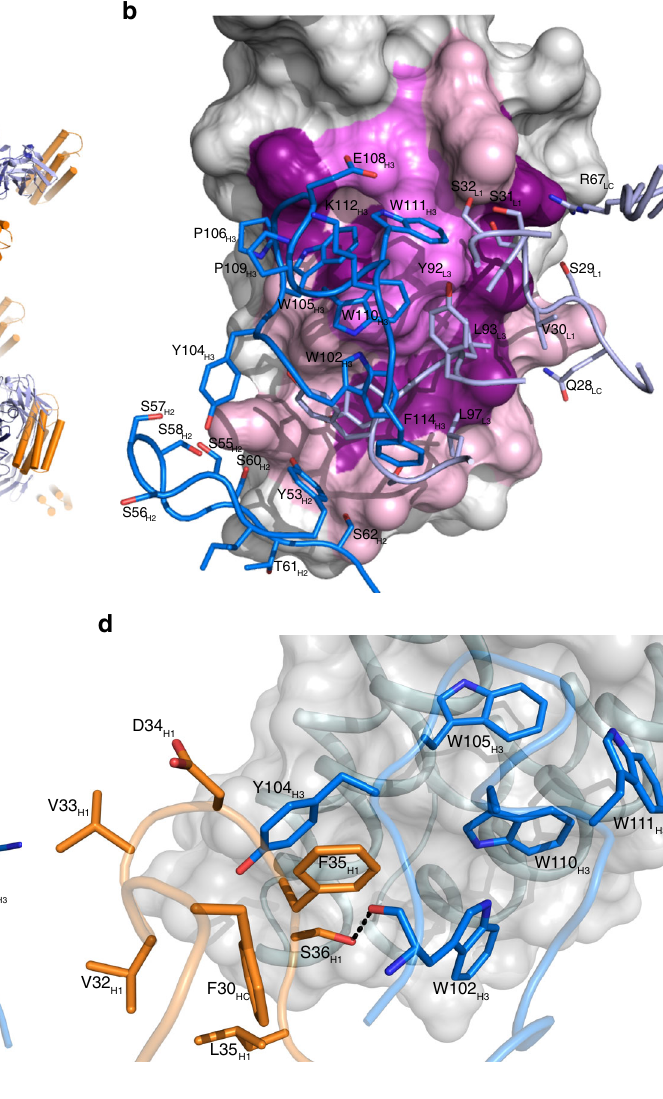
proteins . To gauge the potential versatility of the approach for membrane proteins other than GPCRs, we fused BRIL to: (i) The Zinc transporter YiiP — where BRIL was inserted by replacing the loop connecting the two helices 1 and 2 and helices 5 and 6 separately; and (ii) The potassium channel KcsA — where the N- term helix (1st 23 aa residues) was replaced by BRIL.